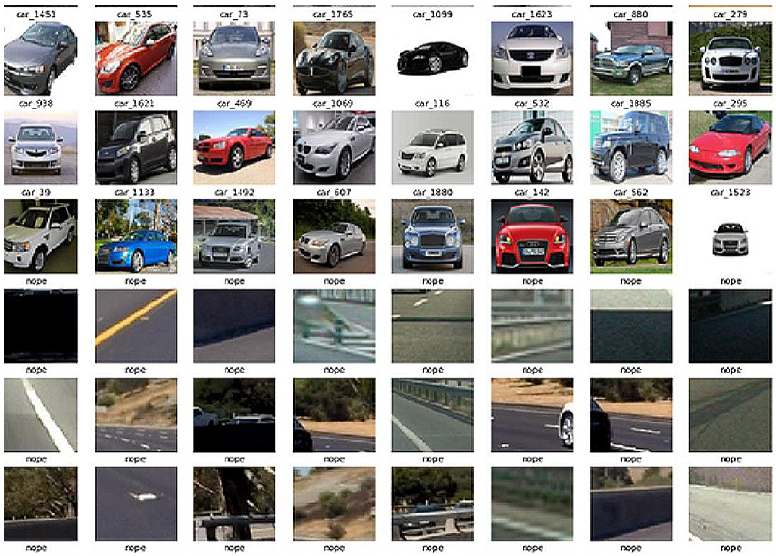
Figure 6. Data visualization of the vehicle and non-vehicle